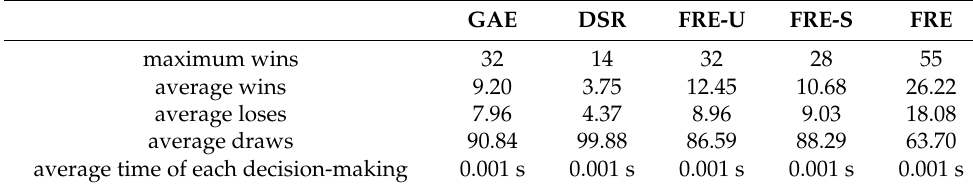
Table 3. Statistical results of evaluations.